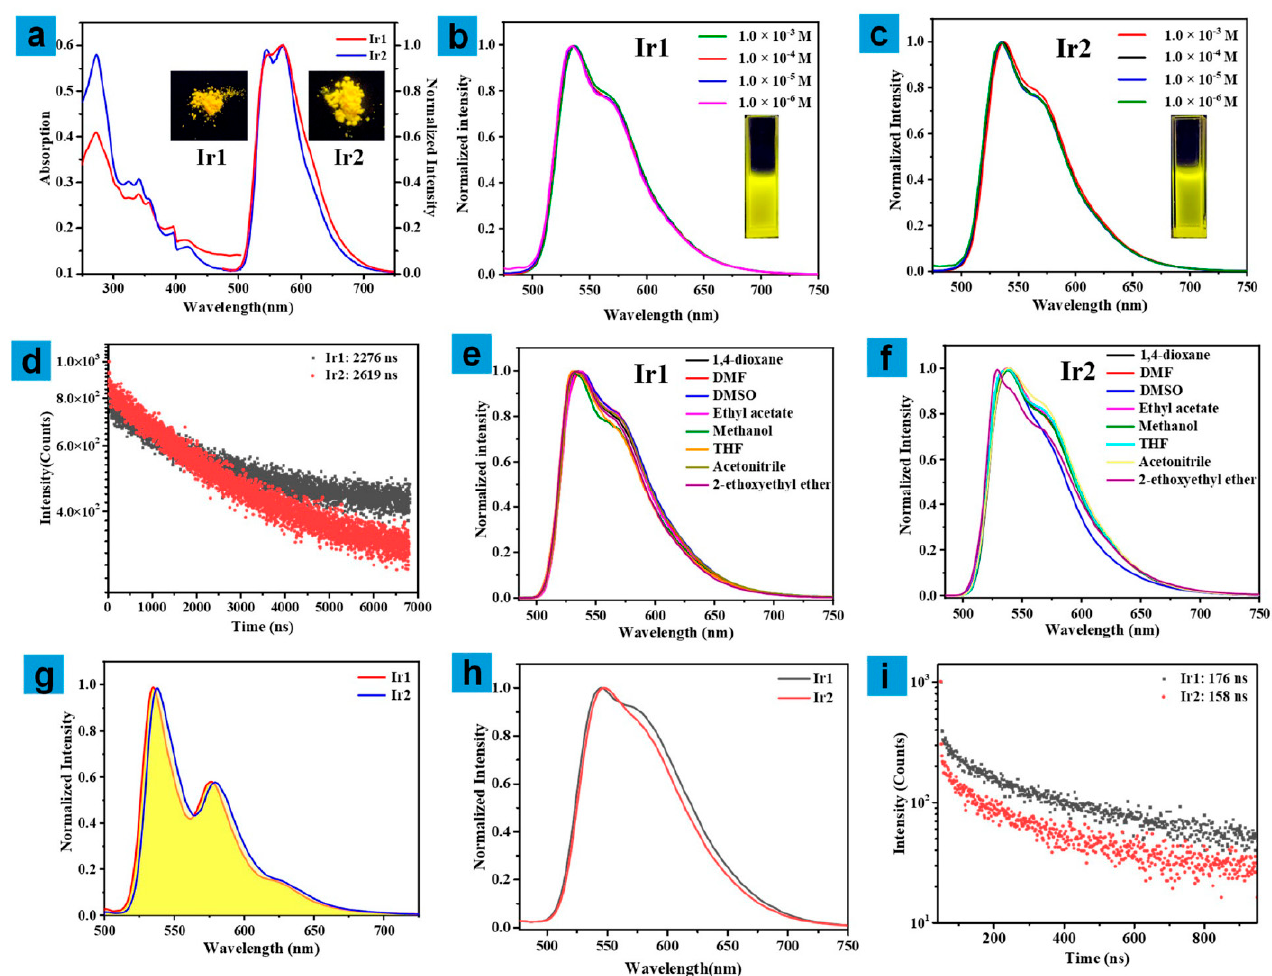
indicates that the phosphorescent emission may occur from a mixture of the LC excited state and metal-to-ligand charge transfer (MLCT) [33].